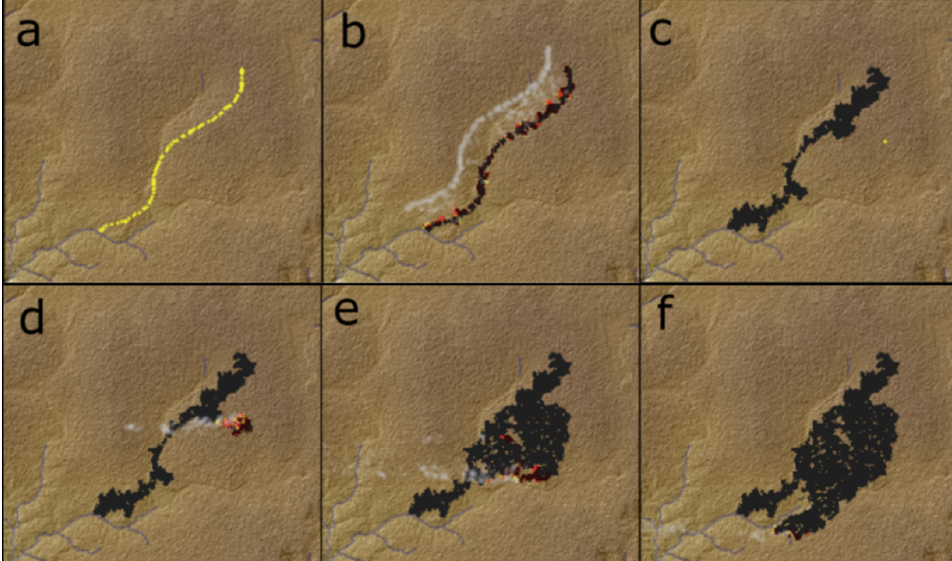
Figure 3. Simulated application of aerial incendiaries to create fire breaks. The sequence ( a – c ) shows what the successful application of incendiaries to create a burnt area might look like with a few gaps that self-extinguished in the evening. In box ( b ) white “smoke” can be seen from the initial ignition Box ( a ) and emanating cells that are still burning. Box ( c ) also shows a simulated ignition point east of the break, with the sequence ( d ) showing fire spread from this point later in the Dry Season with a strong easterly wind. The simulated fire is largely contained from the further westerly spread by Day 2, as shown in box ( e ), but continues to burn slowly around the break before continuing its easterly trajectory, as shown in box ( f ). Were this real, a pattern like this would suggest the need for on-ground intervention to contain the fire front.